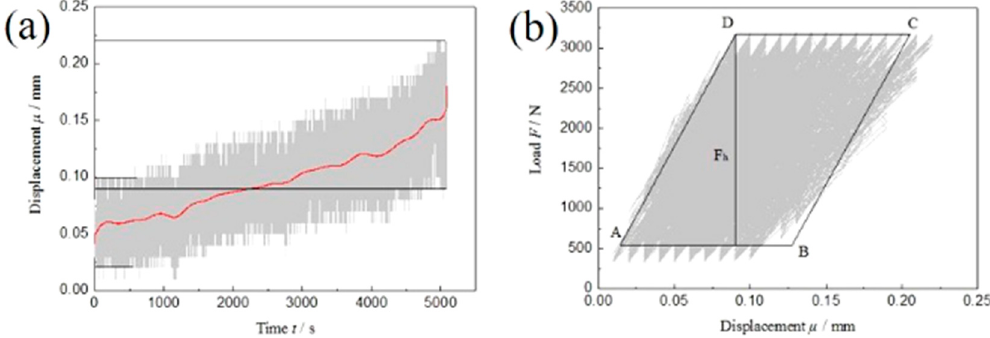
Figure 5. Displacement–time curve ( a ) and load–displacement curve ( b ) of low-frequency asymmetric cyclic load of dissimilar Al/steel keyhole-free FSSW joints.